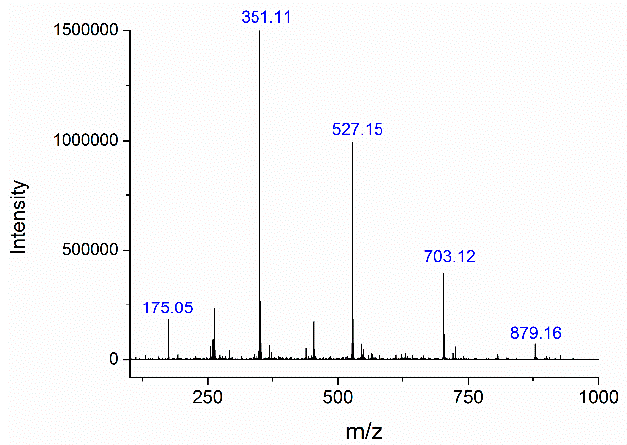
Figure 8. Electrospray ionization-mass spectrometry analysis of the lytic products of citrus pectin produced by PpPel10a.